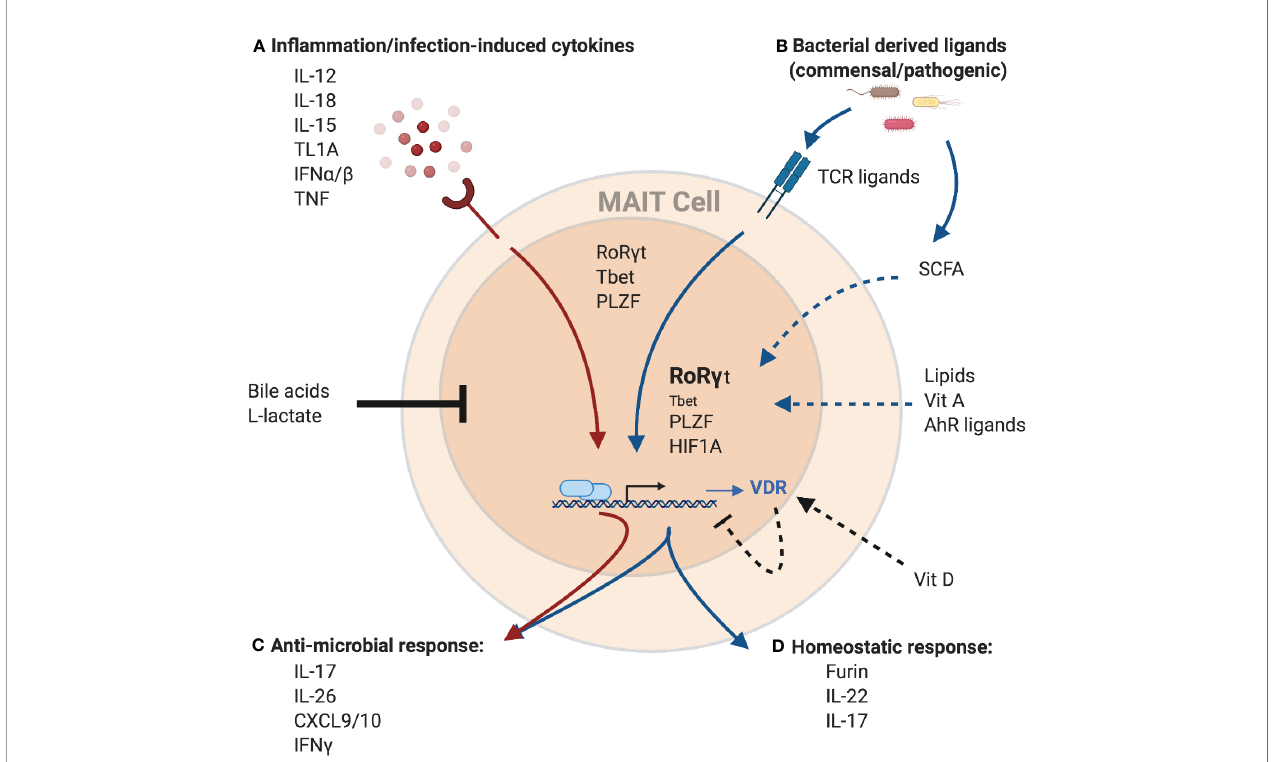
FIGURE 2 | Potential regulation of the MAIT cell transcriptome and effector function by environmental cues. MAIT cells can be activated (A) independent of TCR- ligands by cytokines, or (B) through TCR-mediated recognition of microbial-derived ribo fl avin derivates presented by MR1. These signals can work both independently and synergistically to induce a spectrum of different effector programs. Cytokine-mediated MAIT activation results in the induction of a strong anti- microbial program (C), including the production of cytokines like IFN g , IL-26 and members of the IL-17 family as well as pro-in fl ammatory chemokines like CXCL9 and CXCL10. These antimicrobial functions are further ampli fi ed with concurrent TCR signaling. TCR signals result in the induction of a homeostatic response (D) , including cytokines associated with barrier maintenance (IL-22, IL-17), and proteins associated with tissue repair, such as the endoprotease furin. MAIT cells effector functions are controlled by the transcription factors PLZF, RoR g t, and Tbet. Importantly, while PLZF expression within MAITs is stable, expression of the homeostatic effector program is associated with increased expression of RoR g t and decreased expression of Tbet. Finally, TCR-mediated MAIT cell activation also leads to expression of HIF1A, another transcription factor associated with tissue repair. In addition to TCR-ligands and cytokines, several other factors have the potential to modulate MAIT cell activation. Bile acids and L-lactate were shown to generally reduce MAIT cell responses, while binding of Vitamin D to its receptor (VDR), the expression of which is upregulated in MAIT cells in response to TCR-signaling, has the potential to speci fi cally inhibit the homeostatic response. In contrast, recognition of several other metabolites including AhR ligands, Vitamin A and lipids was associated with the expression of homeostatic effector molecules in other T cell populations and hence, could positively in fl uence the expression of these molecules in MAIT cells as well. Similarly, short-chain fatty acids (SCFA), a product of bacterial metabolism, were shown to stimulate production of IL-22 and expansion of ROR g t-expression lymphocytes in other immune cells, while reducing the antimicrobial function of MAIT cells, which could overall present a mechanism to preserve tissue homeostasis. Created with